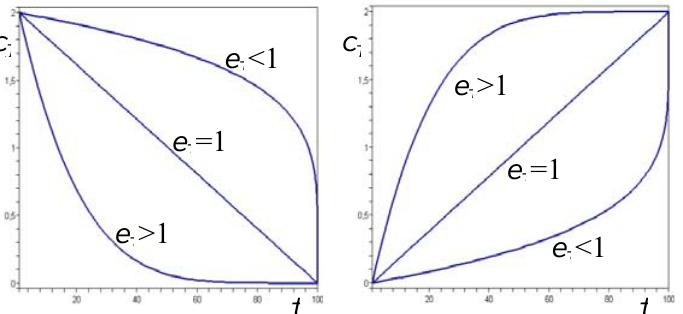
according to the value of e j